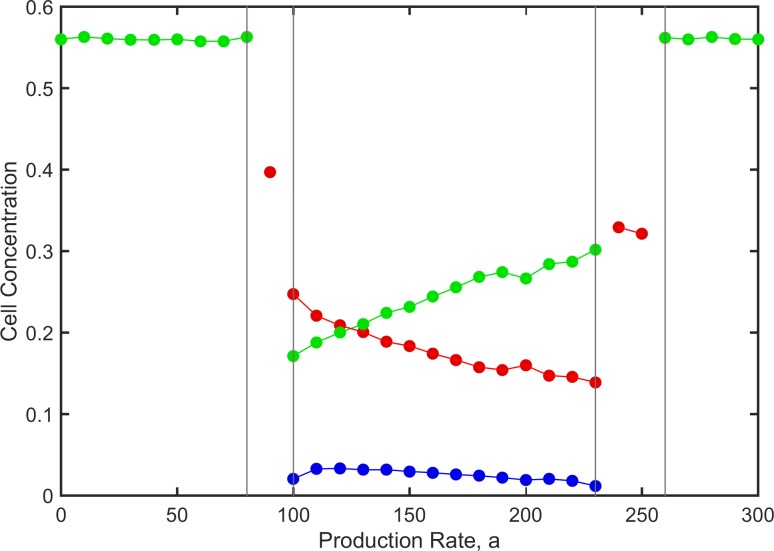
Time averaged cell concentrations for the surviving cell types as a function of a.Parameters as in Fig 4. P—red; N—blue; S—green.